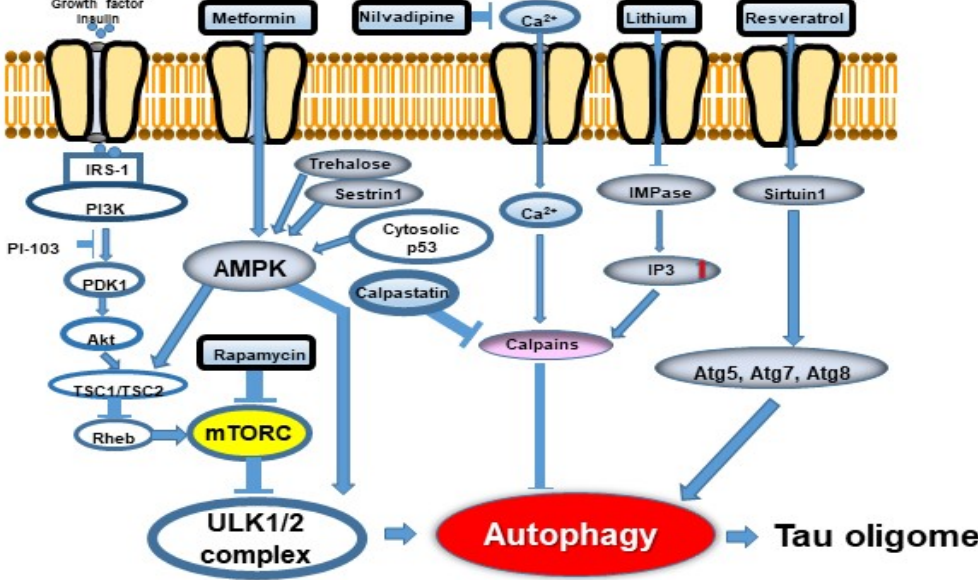
Figure 5. Autophagy flux and potentially effective drugs. Two signaling pathways, mTORC1-dependent and -independent, are involved in autophagy regulation. Abbreviations: mTORC1: mechanistic target of rapamycin 1; IRS-1: insulin receptor substrate-1; PI3K: phosphoinositide 3-kinase; SIRT1: sirtuin 1 (revised from Curr. Alzheimer Res. 2018, 15, 1283-1296 [25].